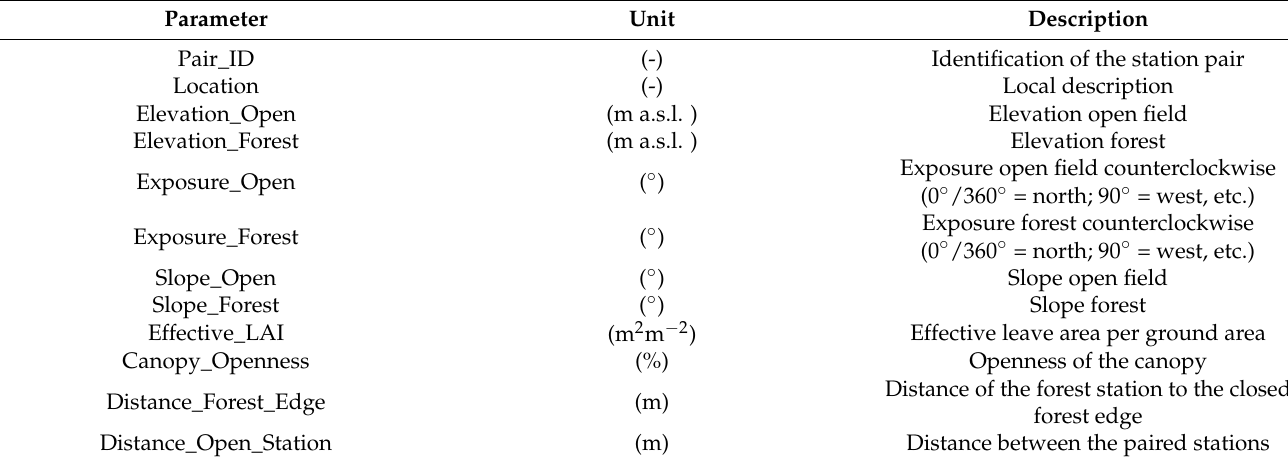
Table 2. Parameters of the metadata with the respective unit and a short explanation.